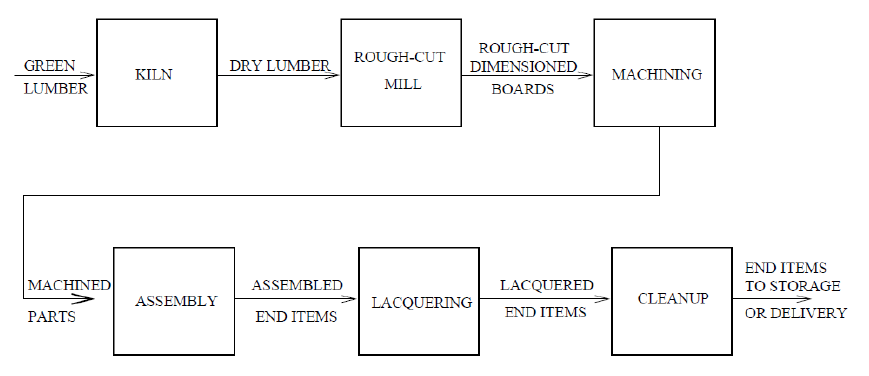
Fig. 6 The flow chart of leg shape parameter